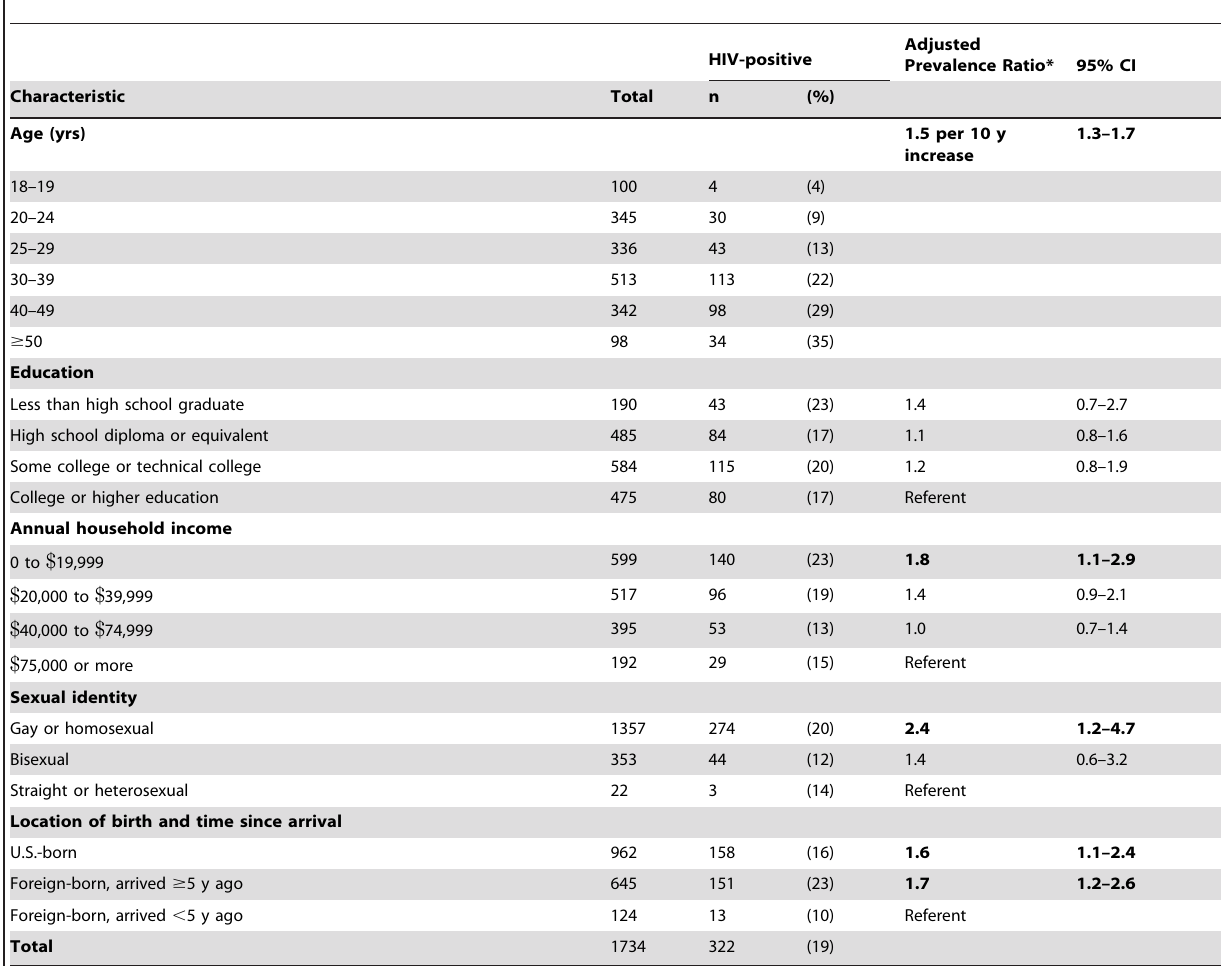
Table 3. HIV prevalence among Latino MSM by selected characteristics and adjusted risk of prevalent infection – 20 U.S. Cities, National HIV Behavioral Surveillance System,